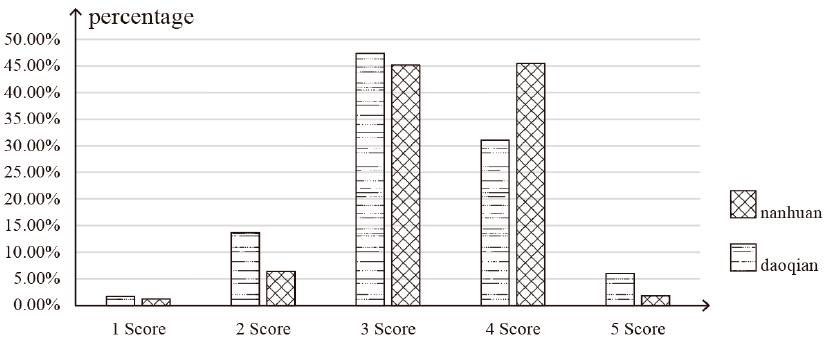
Figure 6. Frequency distribution of satisfaction.